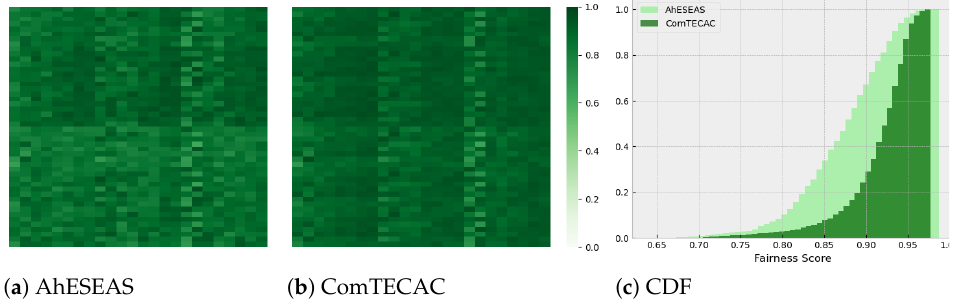
Figure 11. Recomputed fairness for recent clusters scenarios considering AhESEAS and ComTECAC heuristics only (dark is